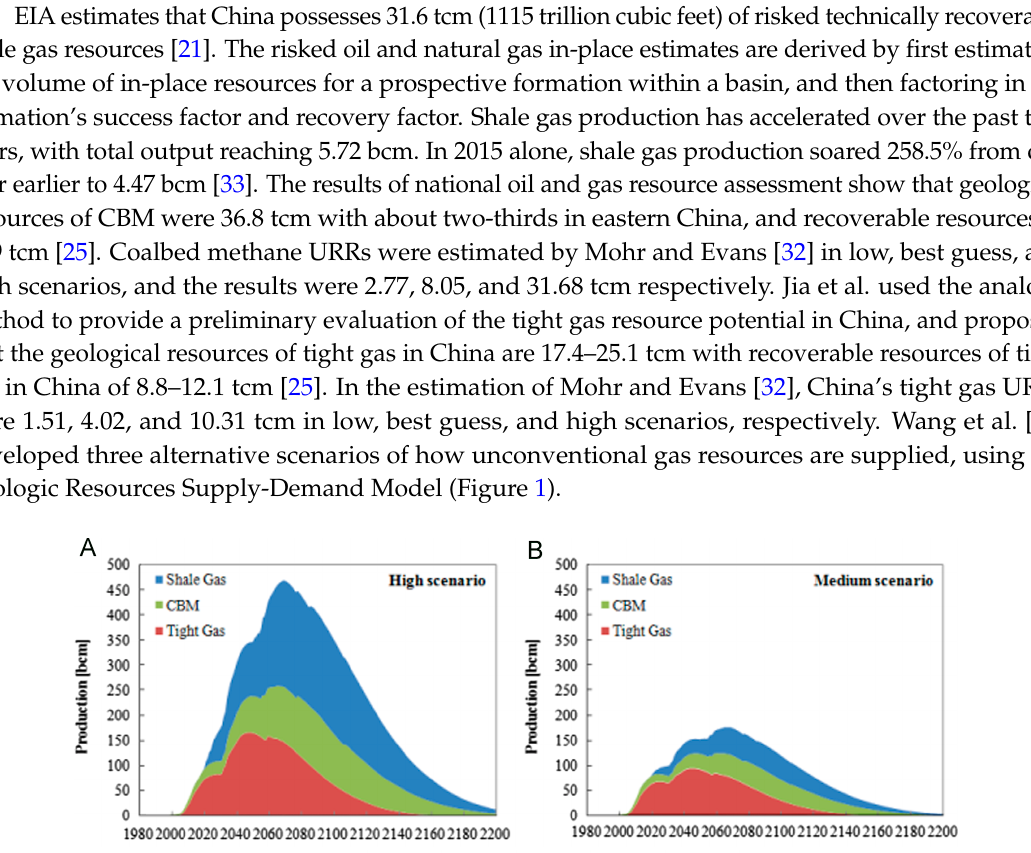
Table 1. Natural gas resource endowment (in tcm) in China.